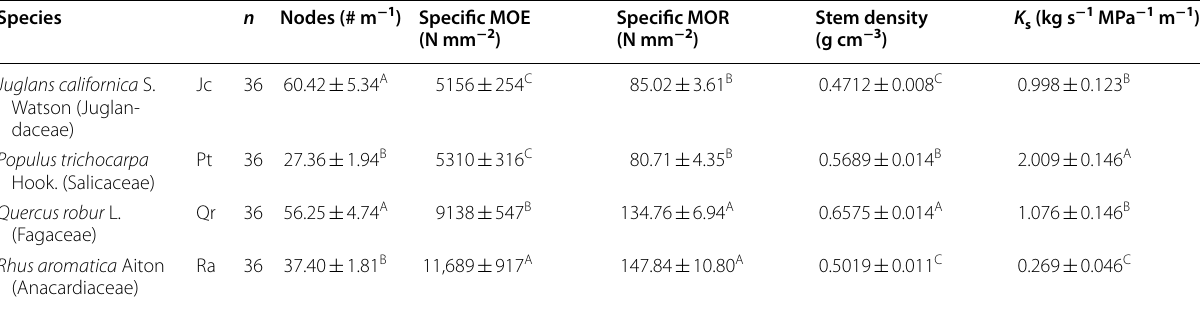
Table 1 Means ( 1 SE) for the biomechanical and hydraulic traits measured across four species, including the frequency ± of nodes, modulus of elasticity (MOE), modulus of rupture (MOR), stem density, and xylem-specific hydraulic conductivity ( K s